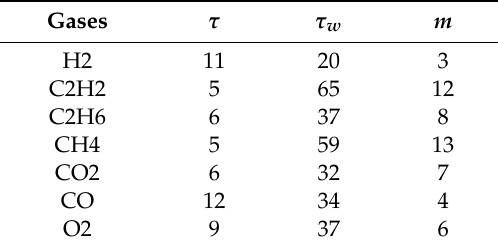
Table 2. The optimal value of τ w , τ , and m for the dissolved gas samples from 23 May 2011 to 8 August 2012 after